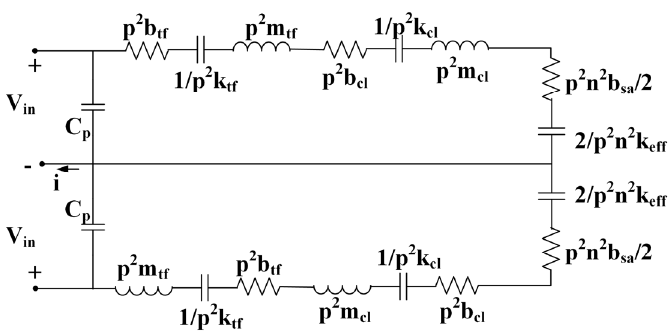
Figure 10. The transformation from mechanical parameters to electrical parameters.